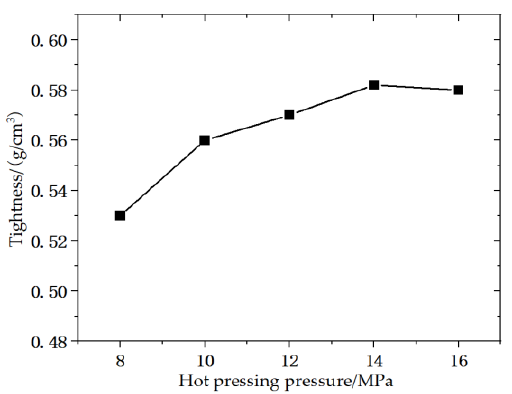
Figure 2. Tightness of insulating paper with different hot pressing pressures.